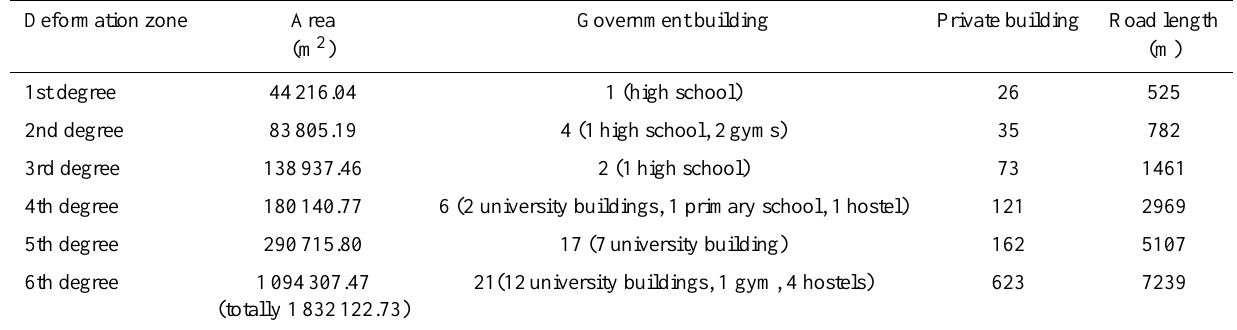
Table 1. Distribution of the structures into the deformation